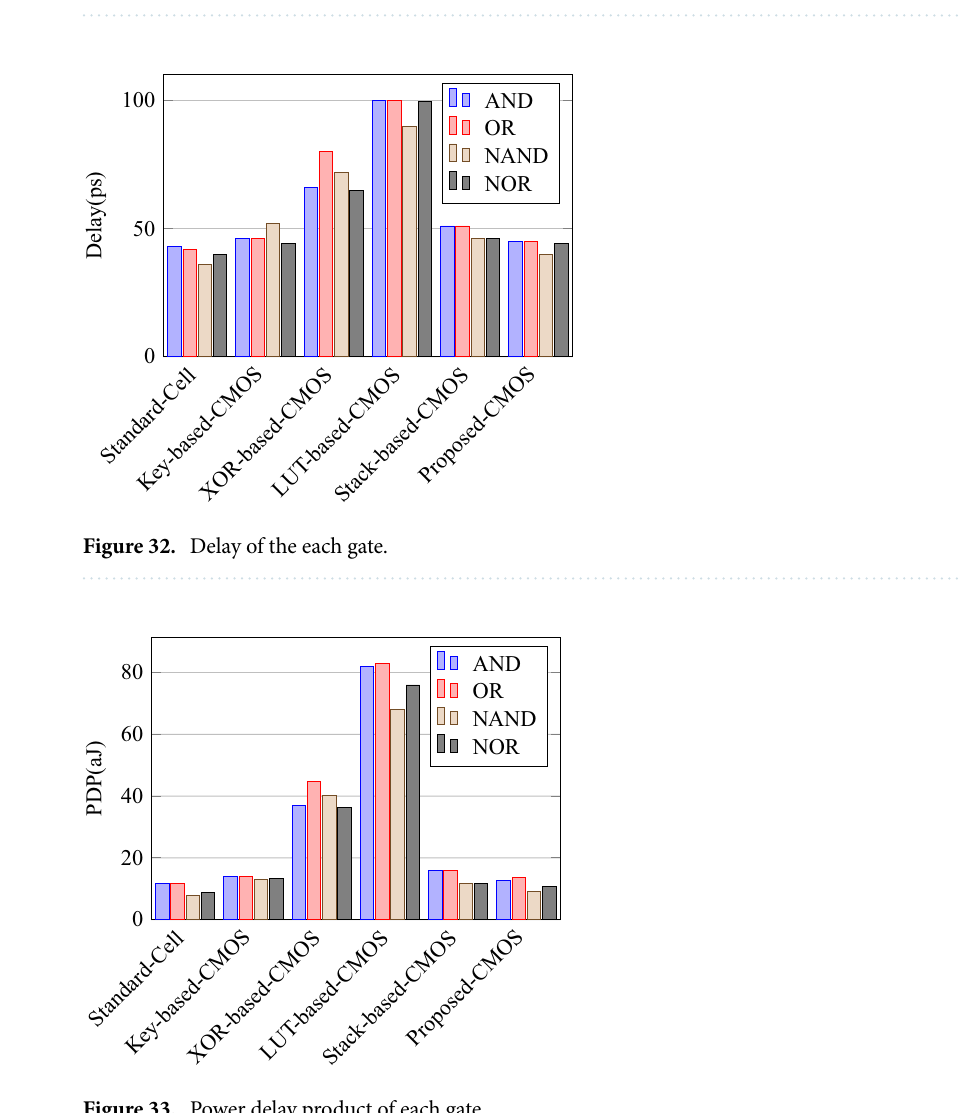
Figure 31. Total area consumed by each gate.